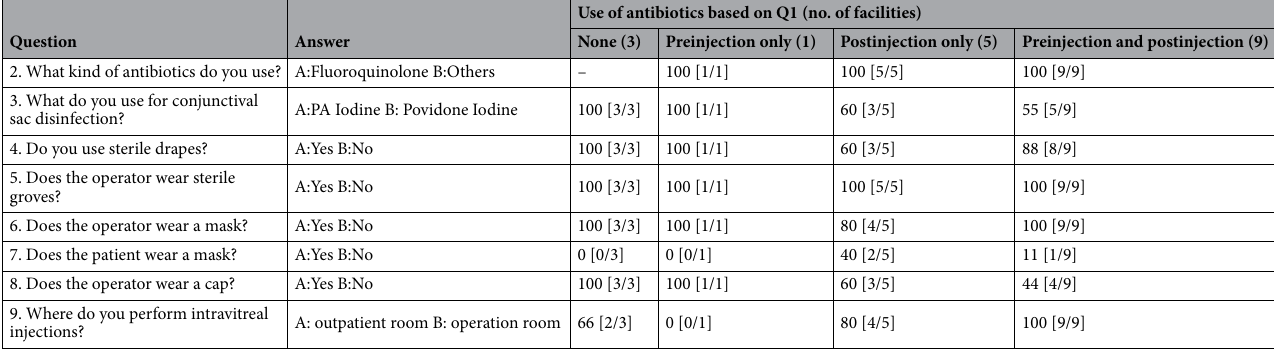
Table 1. The results of the questionnaire. The number shows the percentage of answer A.